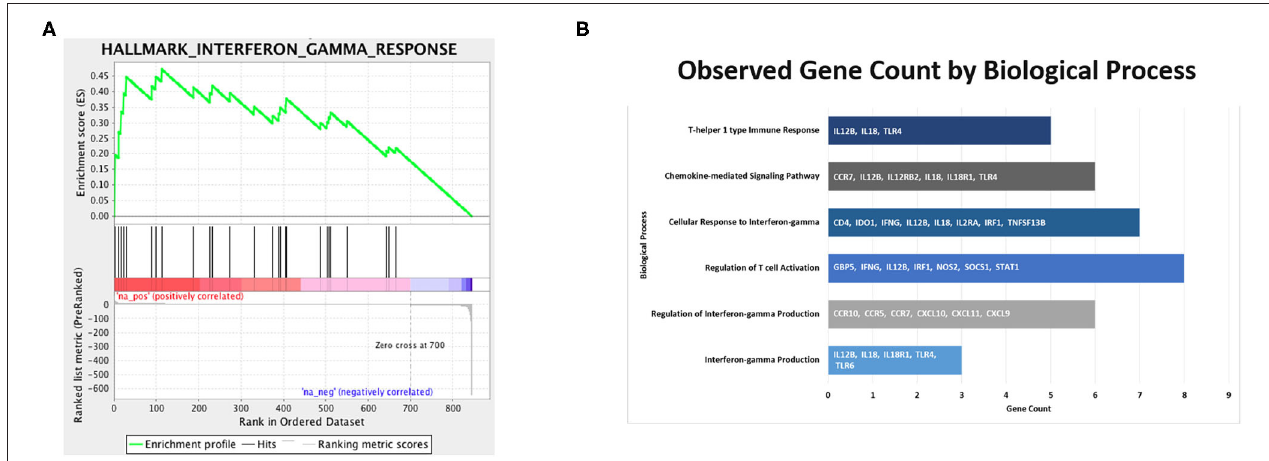
FIGURE 4 | Immune pathways of interest expressed in samples of active localized scleroderma subjects. Significant DEGs were related to known biological, molecular, and cellular processes including T cell migration, activation, and aggregation, and interferon gamma based on GSEA © (A) and GO (B) enrichment